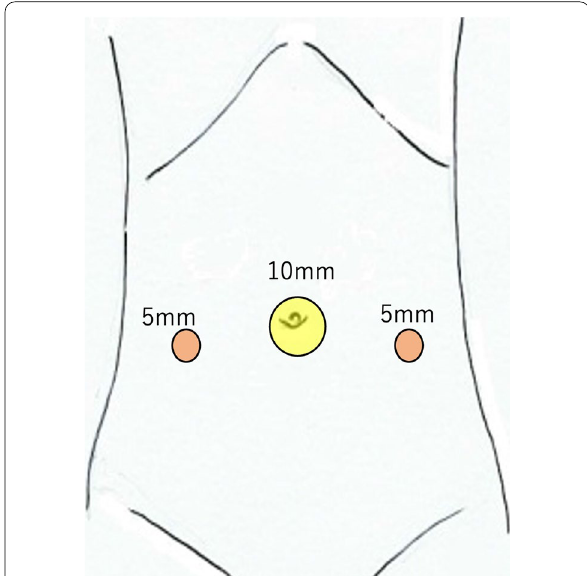
Fig. 2 Port site placement. The image shows the three ports of laparoscopic surgery. The umbilical port is a 12-mm camera port (yellow circle), and the bilateral abdomen port is a 5-mm working port for handling the forceps (red